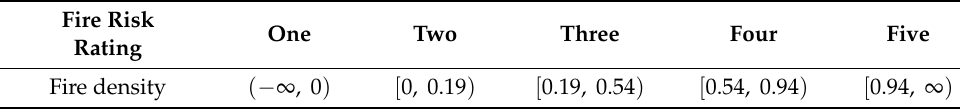
Table 1. Classification of forest fire danger rating